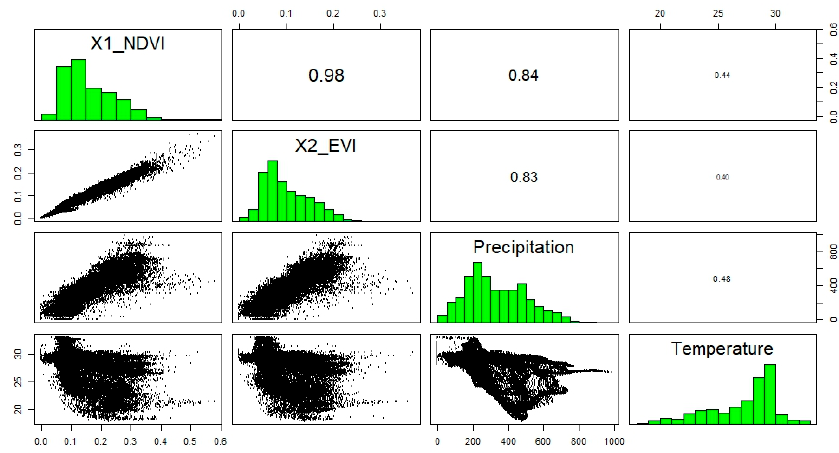
Figure 6. Pair-wise Pearson Correlation Coefficient (PCC) of mean annual NDVI ( X1 ), EVI ( X2 ), temperature, and average annual total precipitation during 2000–2017. The numbers represent average PCC values, and strong and weak correlations donated by large and small font sizes, respectively.